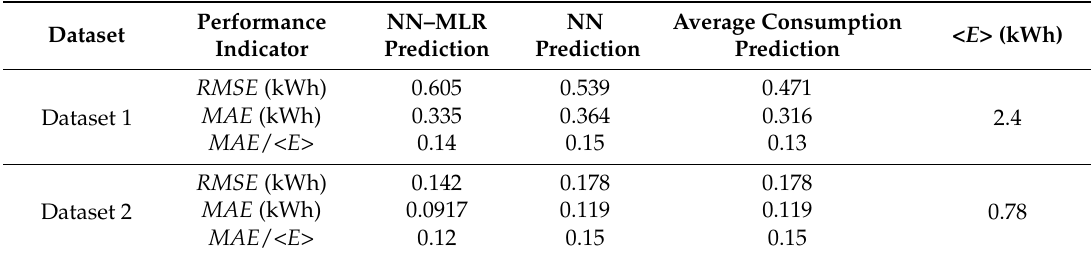
Table 5. Performance indicators for the energy prediction model and the two benchmark models for comparison on trip level.